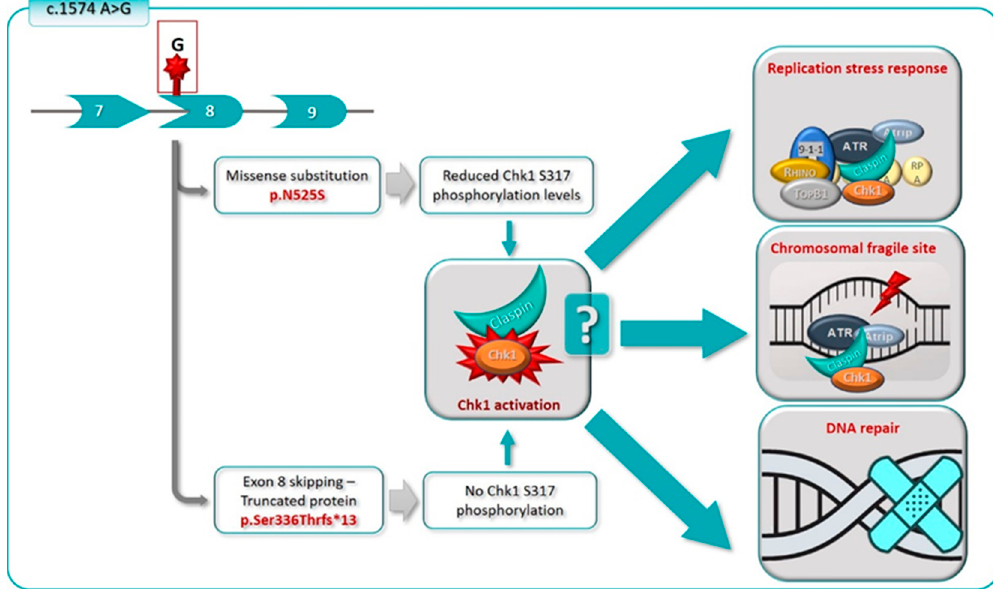
Figure 9. CLSPN c.1574A>G variants may impact multiple Claspin’s functions. p.Asn525Ser mutant is defective in its ability to phosphorylate Chk1, and can, therefore, affect checkpoint activation. In addition, as it is located at Claspin’s RFID, it may impact Claspin functions in DNA replication, such as maintenance of replication integrity, sensing of aberrant replication structures and the DNA replication process itself. This variant may also cause CLSPN exon 8 skipping, which leads to production of a 349 aa truncated Claspin protein (p.Ser336Thrfs*13) that completely lacks the C-terminal domain. Therefore, this isoform may lead to a defective Claspin’s response to DNA damage and replication checkpoint regulation.